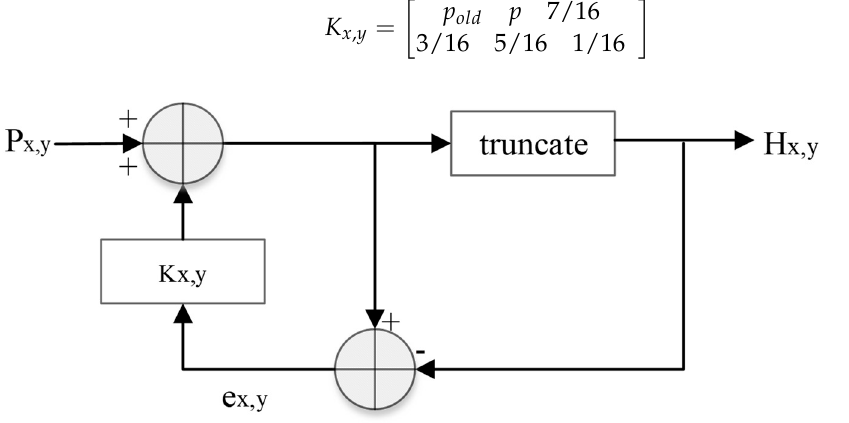
Figure 2. The error-diffusion algorithm.